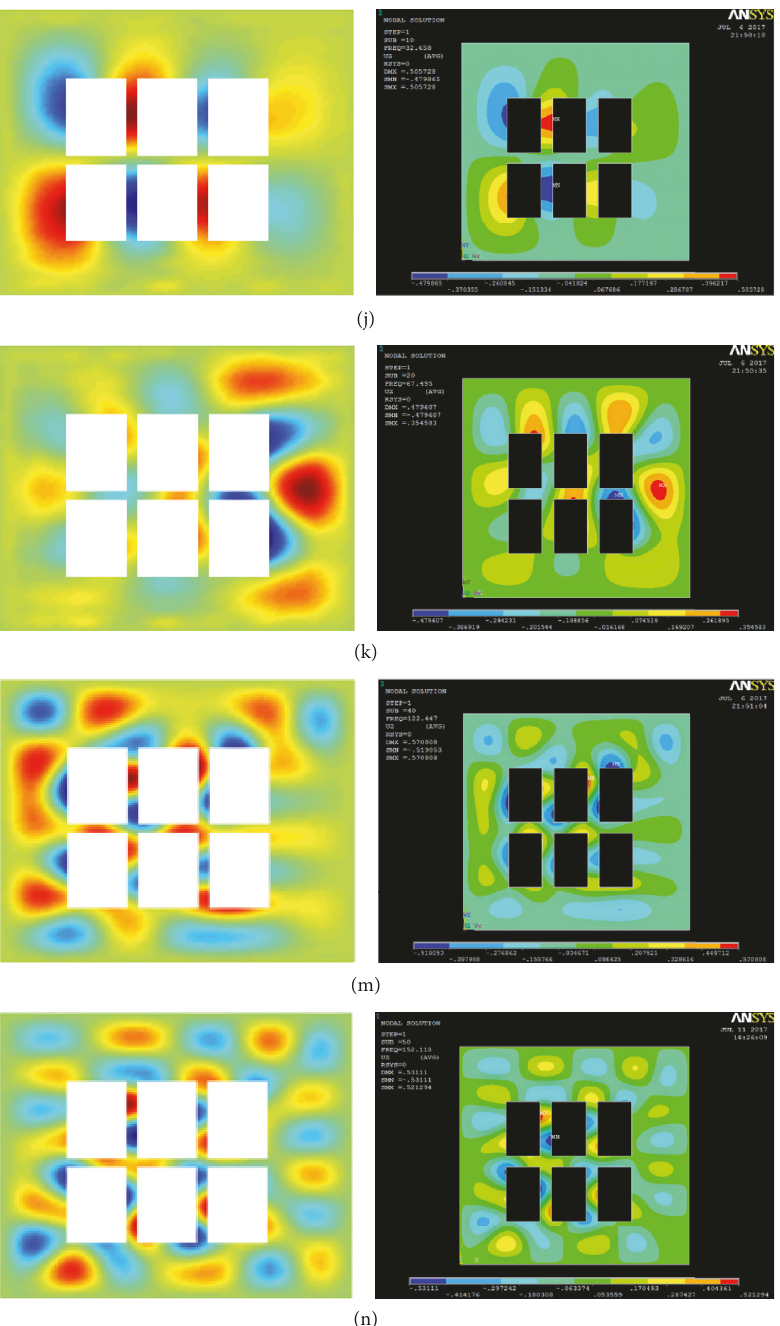
Figure 2: The mode shapes for the flexible plate with six cutouts. (a) The first mode; (b) the second mode; (c) the third mode; (d) the fourth mode; (e) the fifth mode; (j) the tenth mode; (k) the twentieth mode; (m) the fortieth mode; (n) the fiftieth